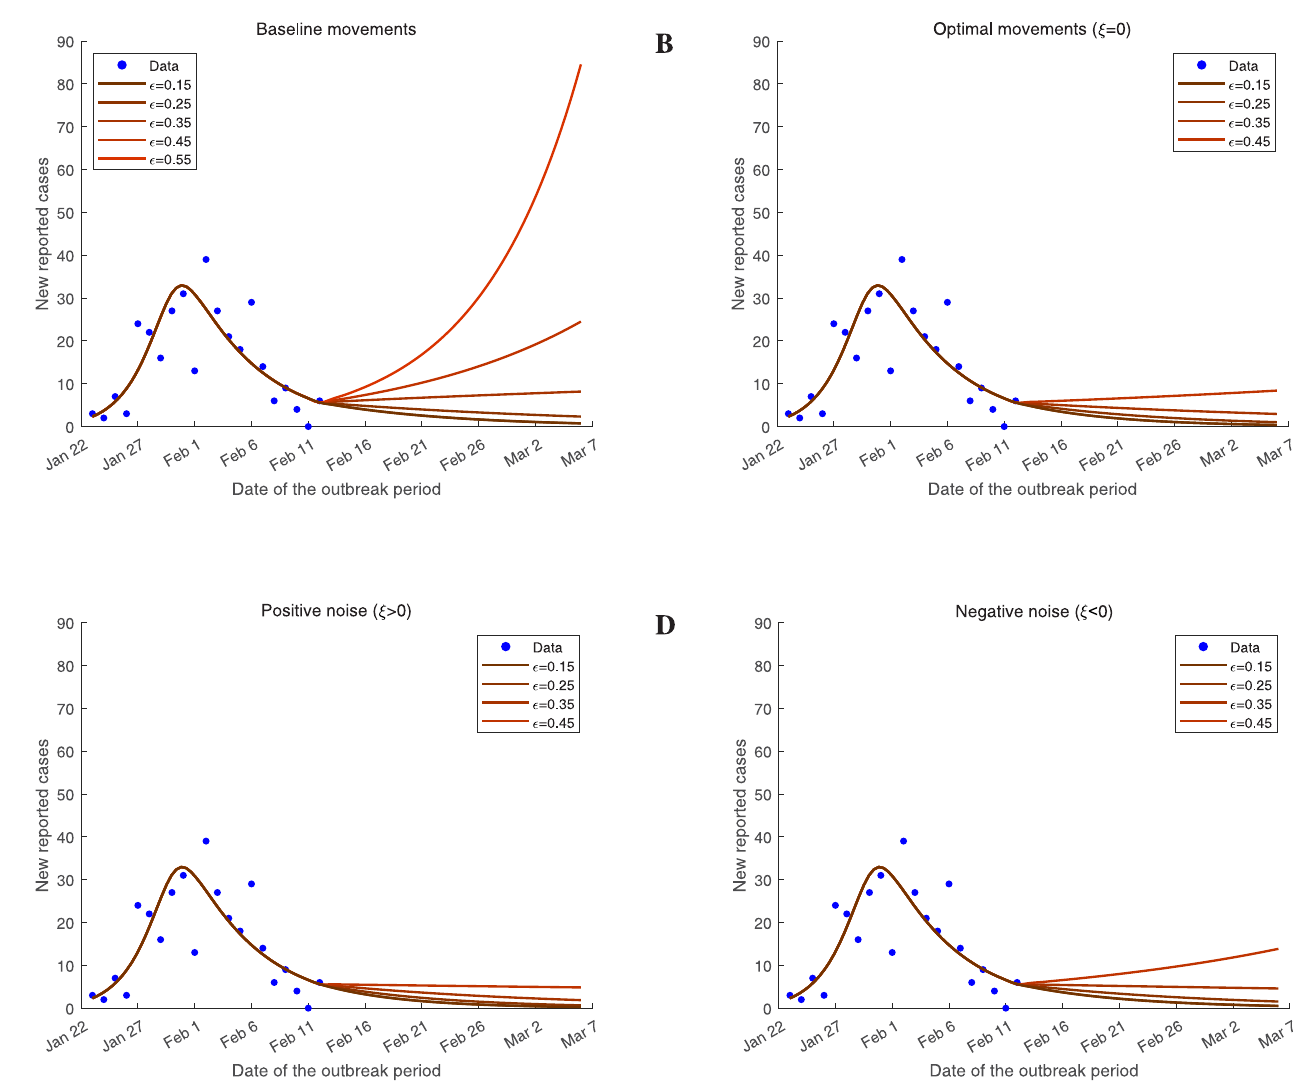
Fig 6. Testable predictions of the number of daily cases reported in Guangzhou under our lockdown exit strategy. A : The baseline movements induce a secondary outbreak of COVID-19 in Guangzhou easily. B : The travel pattern we present does not cause a secondary outbreak. C-D : The simulations based on our travel pattern with positive and negative noise,